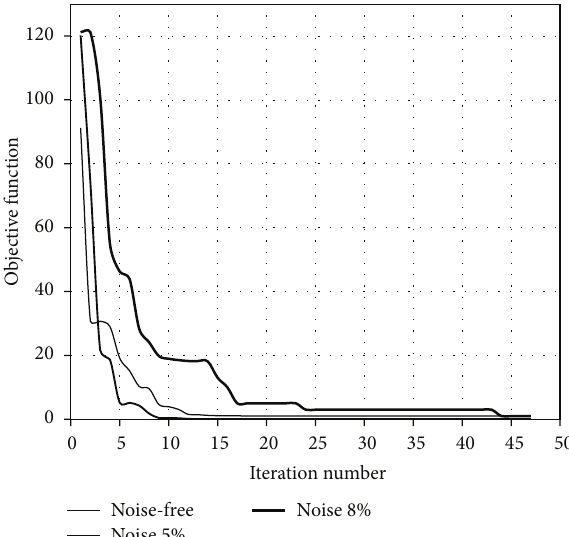
Figure 12: Convergence history of the ICA for the ten-story shear frame for scenario III.